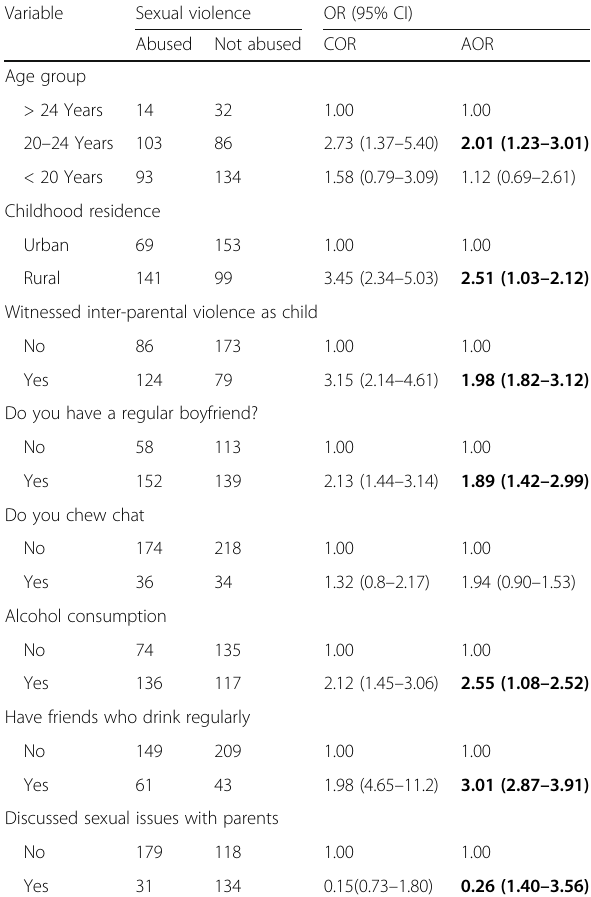
Table 4 Bivariate and multivariate logistic regression